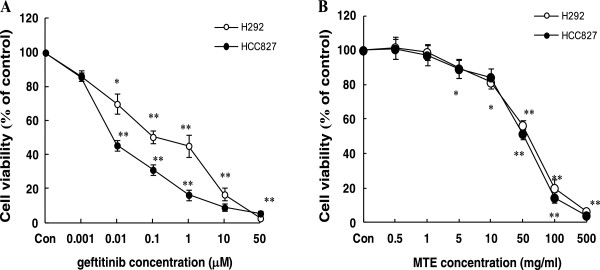
Treatment of non-small cell lung cancer cells with gefitinib or MTE (M. tenacissima extract) reduced their proliferation potential. (A) H292 and HCC827 cells were treated with the indicated concentrations of gefitinib for 72 h. (B) H292 and HCC827 cells were treated with the indicated concentrations of MTE for 72 h. Cells viability was determined by using the MTT assay as described in the Methods section. The data are expressed in terms of percent of control cells as the means ± SEM. The experiments were repeated at least three times. *P < 0.05, **P < 0.01 vs. control group.